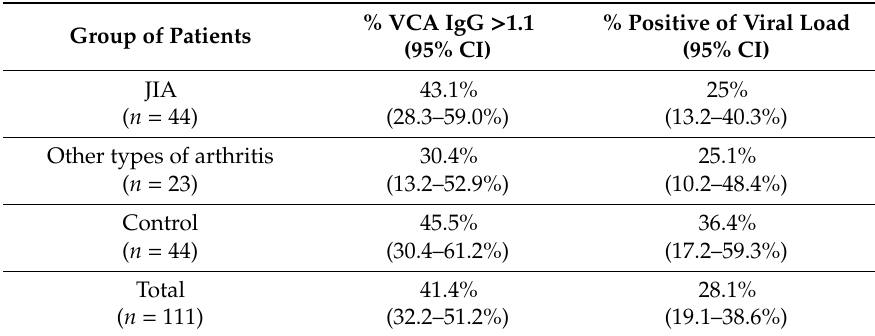
Table 5. Prevalence of positive anti-VCA IgG ( > 1.1 U / mL) and viral load test in patients with JIA, other types of arthritis, and controls; CI—confidence